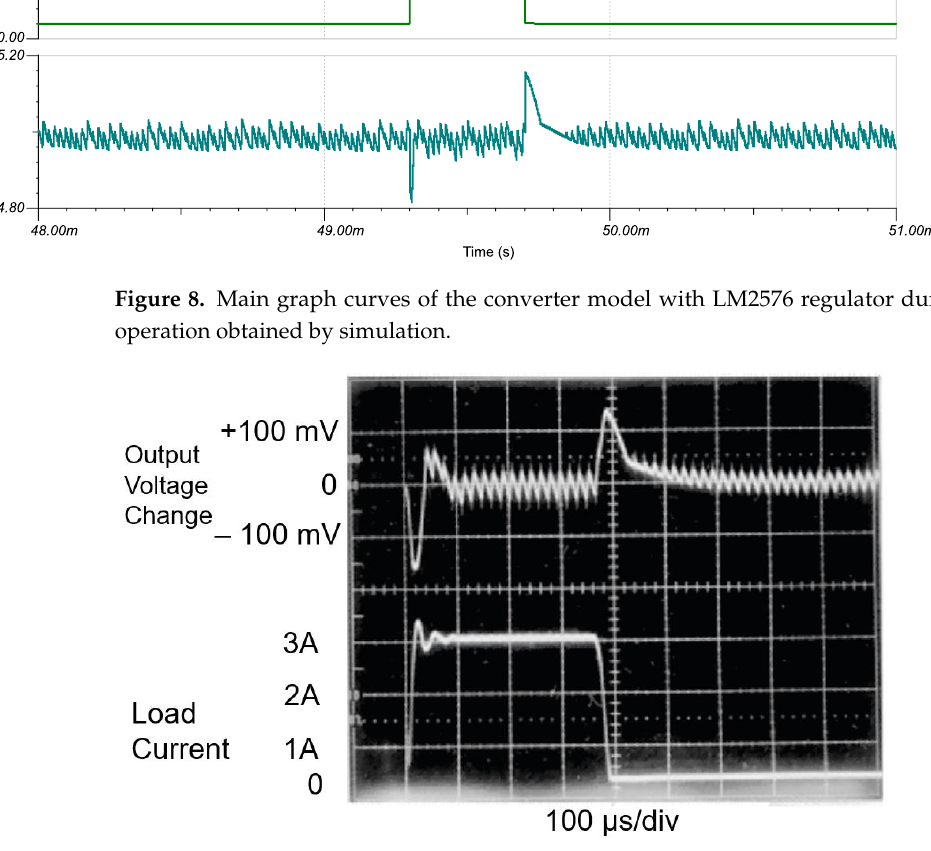
Figure 9. Main graph curves of the converter with the LM2576 regulator during its dynamic operation obtained from the regulator datasheet.